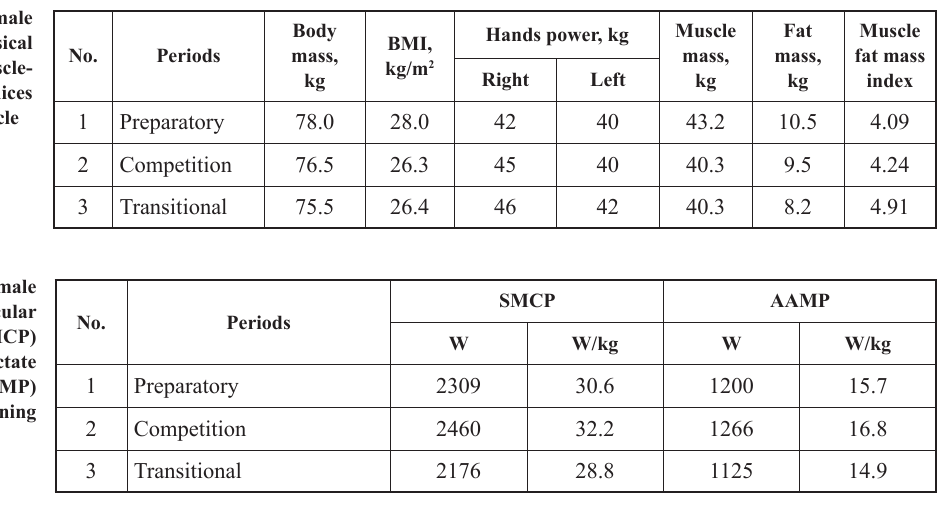
Table 3. Alternation of female BMX cyclist’s physical powers during